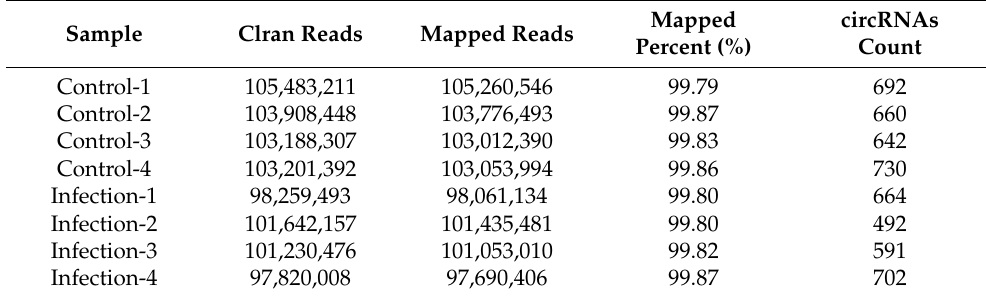
Table 1. Circular RNAs raw data